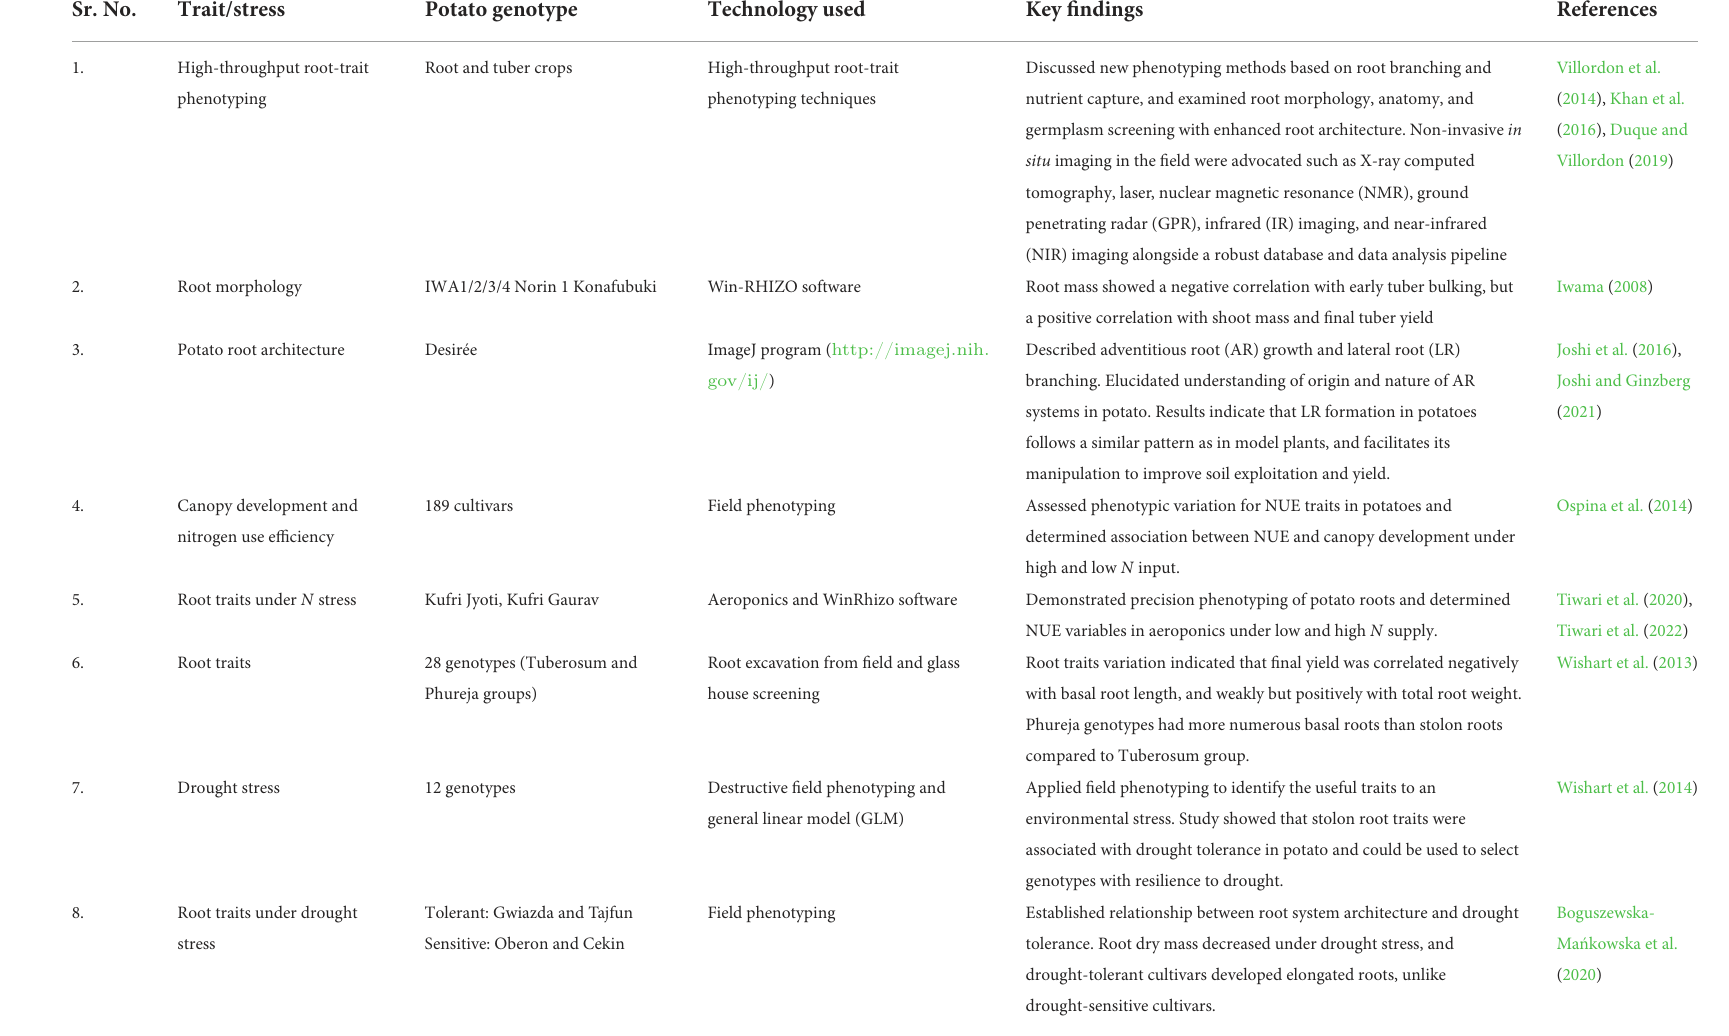
TABLE 1 Root system architecture studies on different abiotic stresses in potato. Sr.